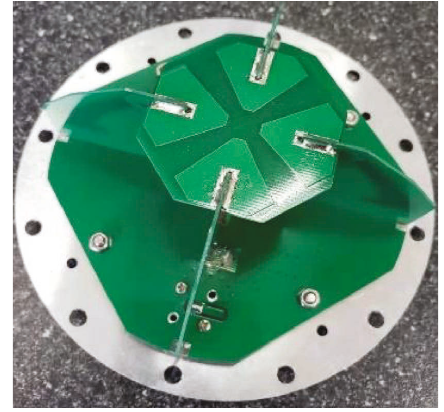
Figure 9: Fabricated antenna.